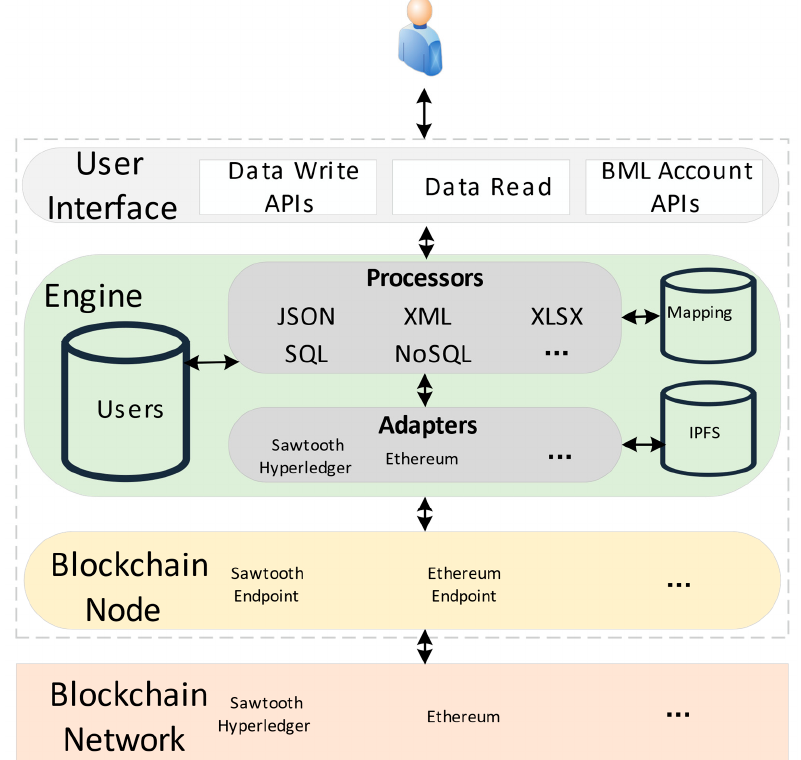
Figure 2. Architecture of BML system.